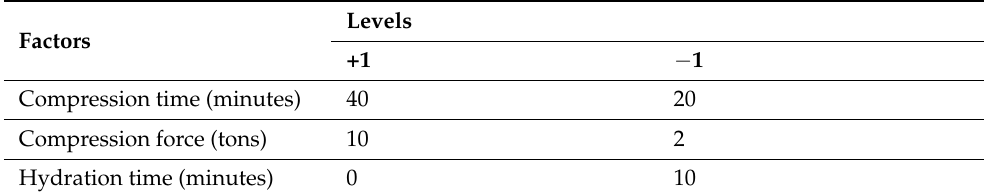
Table 2. Factors and levels of full factorial design 2 3 .